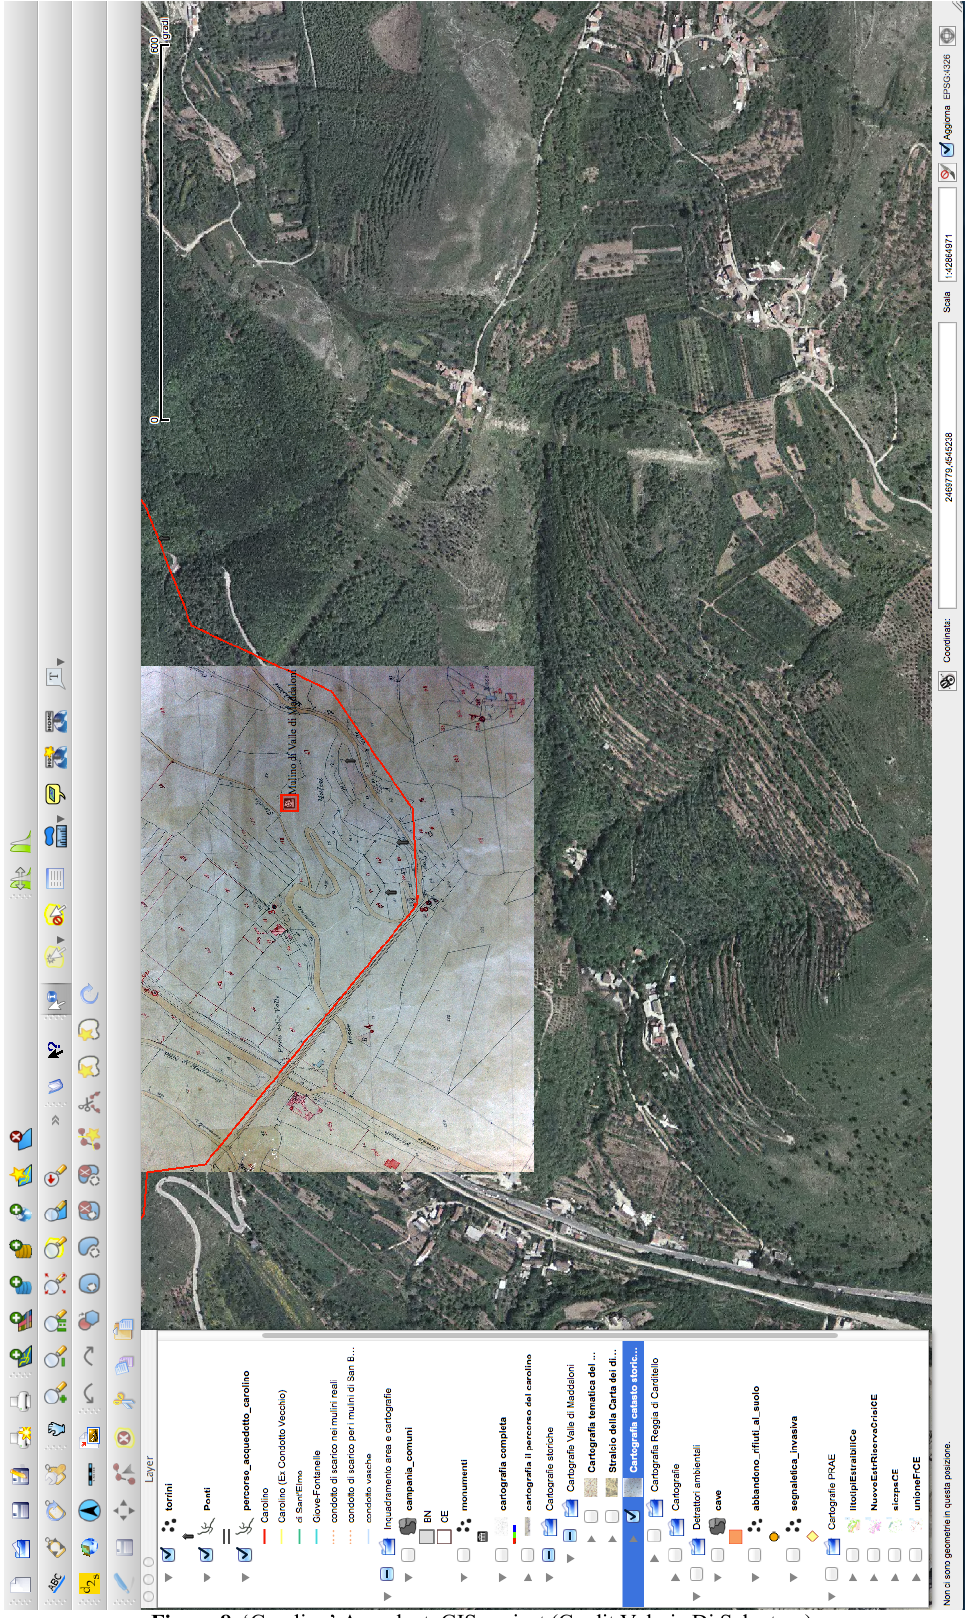
Figure 8 . ‘Carolino’ Aqueduct. GIS project (Credit Valeria Di